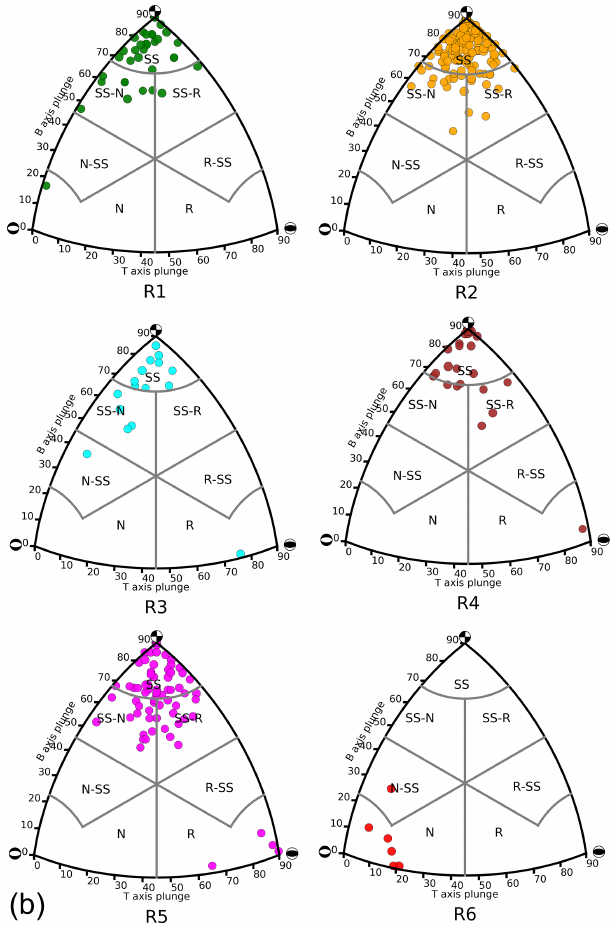
Figure 7. Focal mechanism solutions of oceanic earthquakes in Mexico reported by the Global CMT catalogue from 1976 to 2017. (a) Focal mechanisms are divided into six regions (R1 to R6) for the stress inversion analysis. (b) Focal mechanism classification based on the Kaverina et al. (1996) projection technique implemented by Álvarez-Gómez (2015): reverse, reverse with lateral component, strike-slip with reverse component, strike-slip, strike-slip with nor- mal component, normal with lateral component, and normal (R, R- SS, SS-R, SS, SS-N, N-SS, and N, respectively).